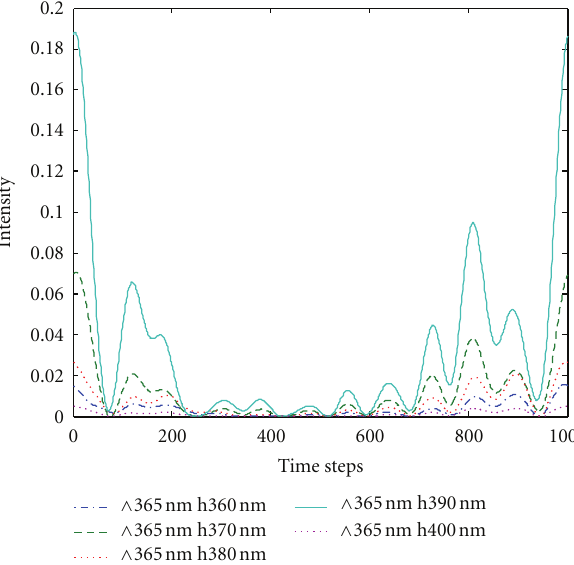
Figure 7: Energy flow of silver film (of di ff erent thicknesses) with a single grating